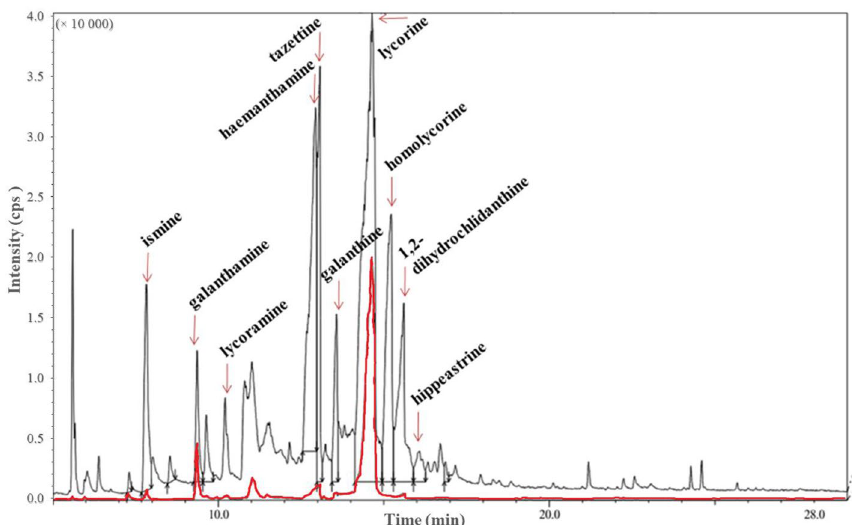
Figure 2. GC–MS total ion current chromatograms of the alkaloid fraction from Paenibacillus lautus strain PLV extract (upper trace) and alkaloids standard mixture (lower, red-shaded trace), acquired in scan mode. Identification based on library search, details given in Table